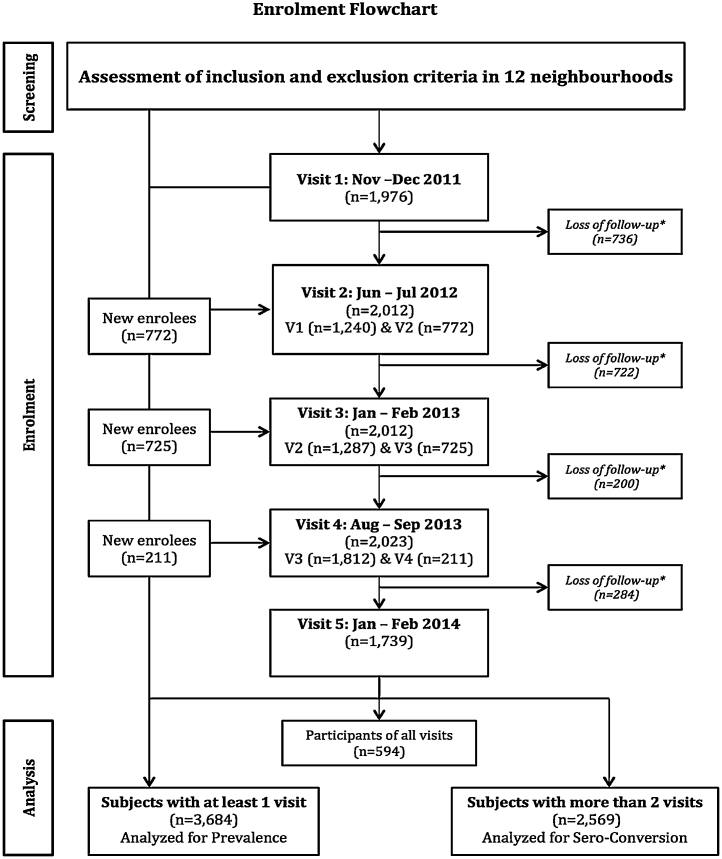
Flow chart of enrollment and participation.